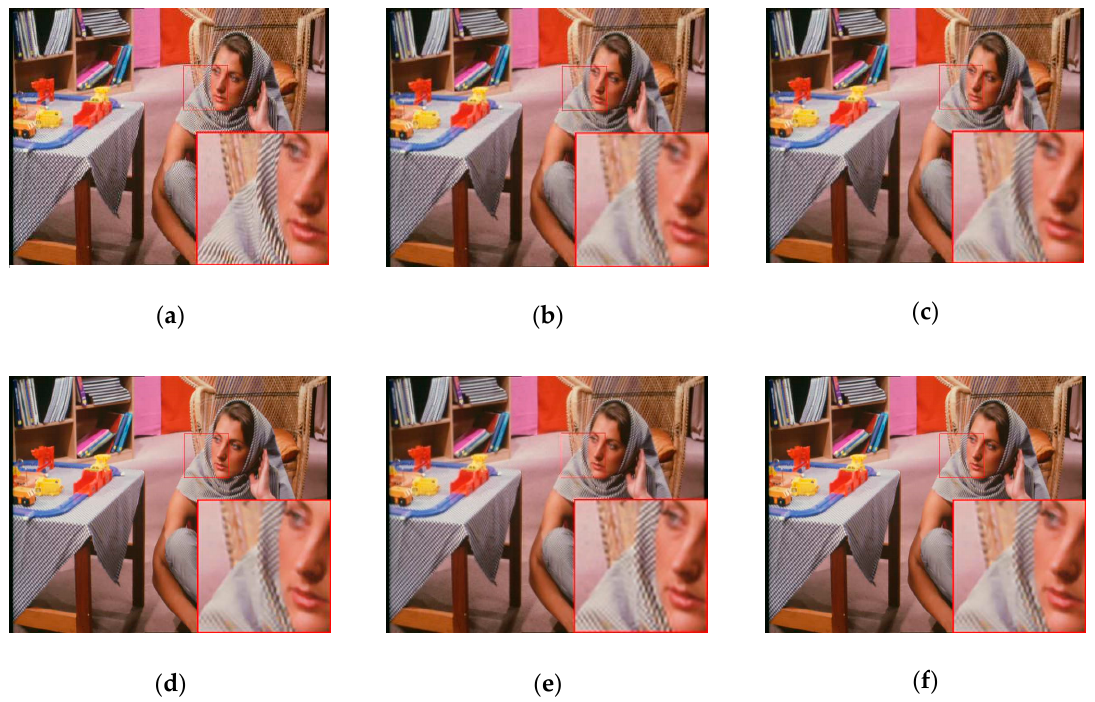
Figure 7. SR results of the image Barbara by different methods. ( a ) Original image. ( b ) BI. ( c ) SAI. ( d ) CSC. ( e ) LMCSC. ( f ) SCCSL.